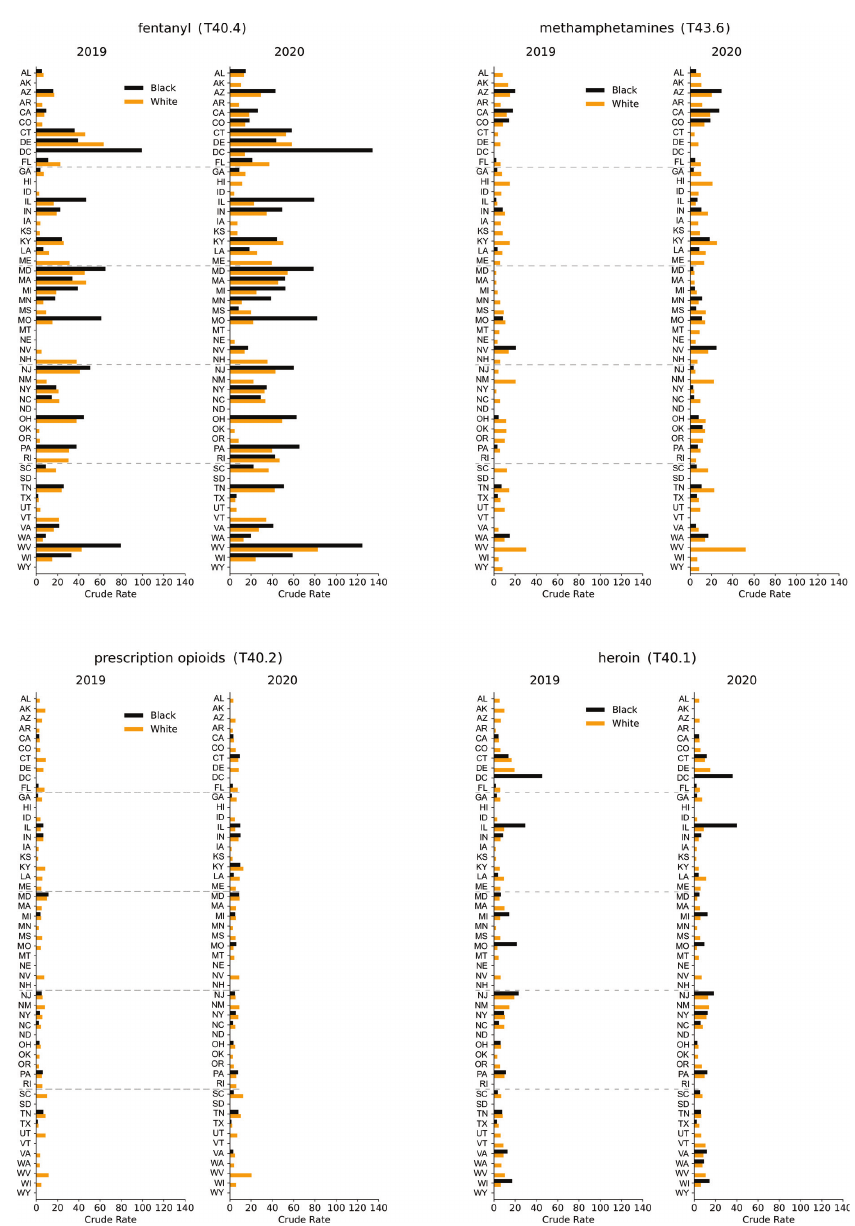
Fig 6. Crude rates for Black and White males across the United States associated with fentanyl (T40.4), methamphetamines (T43.6), prescription opioids (T40.2), heroin (T40.1) for the years 2019 and 2020. Note the racial imbalances and the increase in mortality in the District of Columbia for fentanyl and